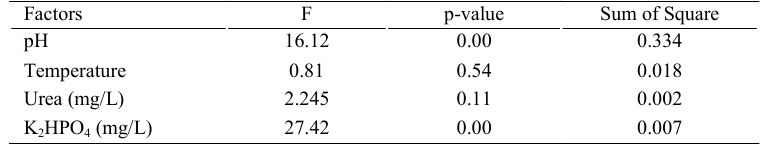
Table 3. Results of One-way ANOVA based on the optical density at the end of the 4-day experiment